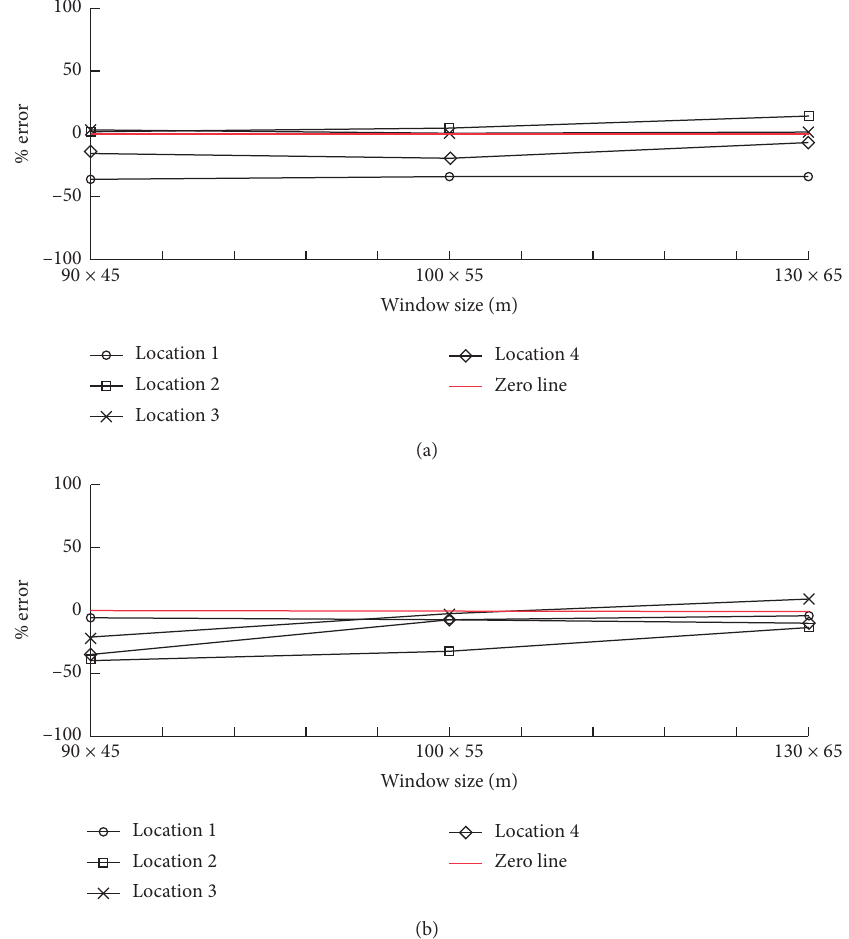
Figure 10: Prediction error of mean trace length associated with finite sample sizes and spatial variability based on new estimation method using rectangular windows of different sizes placed at different locations on the outcrop. (a) Set 1. (b) Set 2.